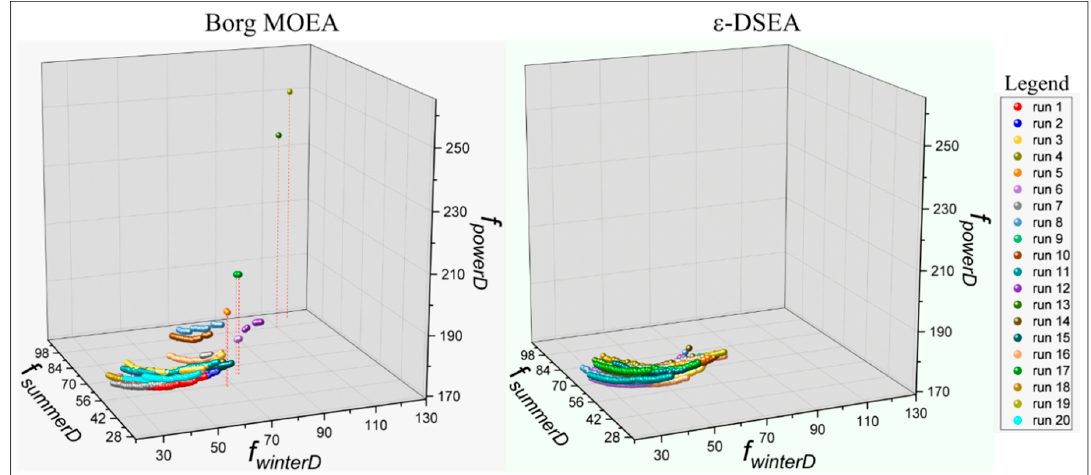
Figure 4. Pareto-fronts for twenty random runs achieved by both algorithms.